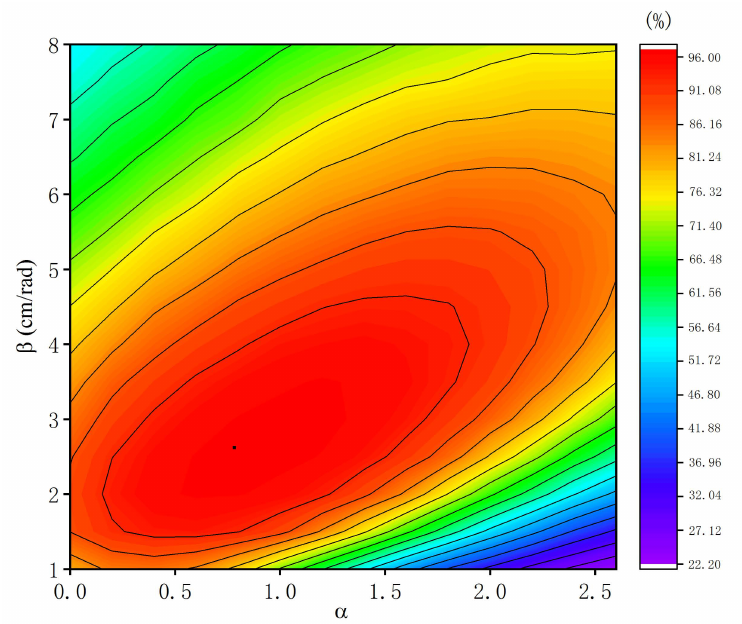
Figure 3. Beam transmission envelope of